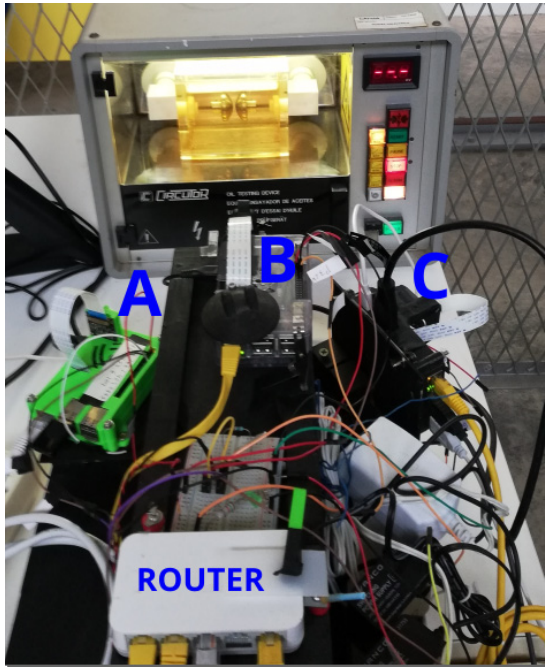
Figure 4. Cameras A, B and C connected with Raspberry Pi and router for the collection of images in a central computer.